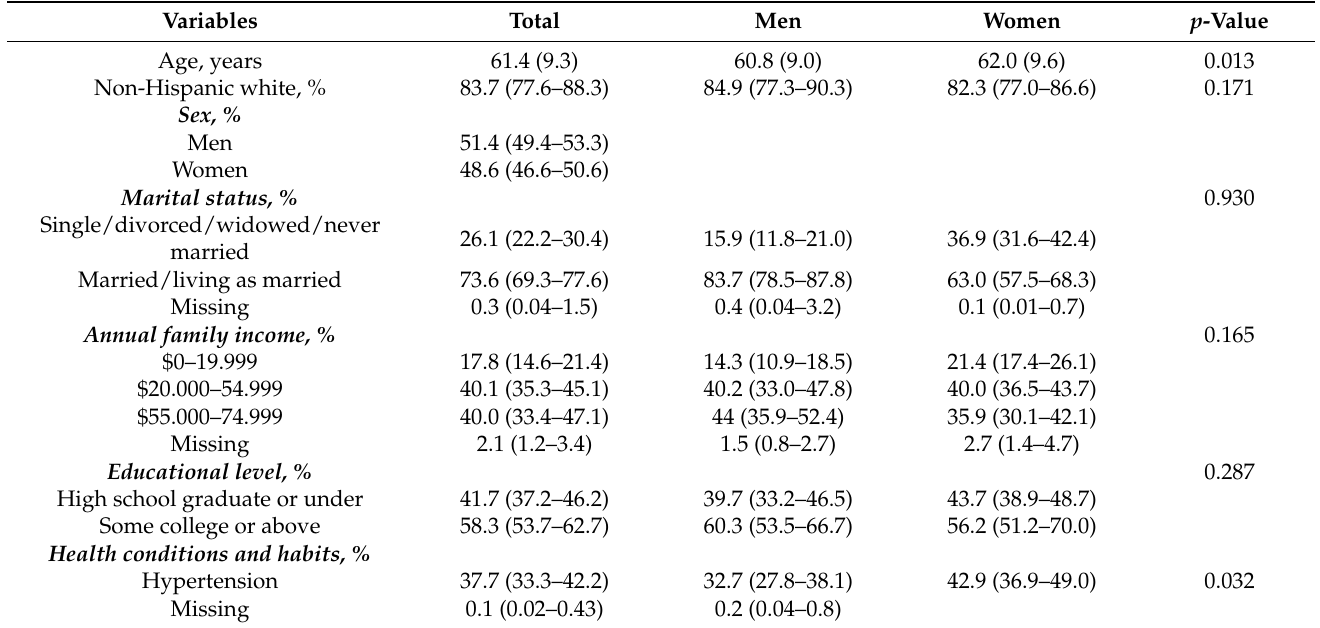
Table 1. Sociodemographic, anthropometric and body composition characteristics of the individuals in the total sample and according to sex. NHANES,